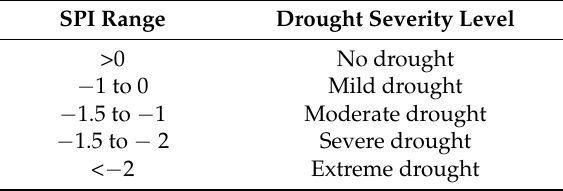
Table 2. Drought classification using SPI based on 4 months CHRIPS daily aggregate dataset.